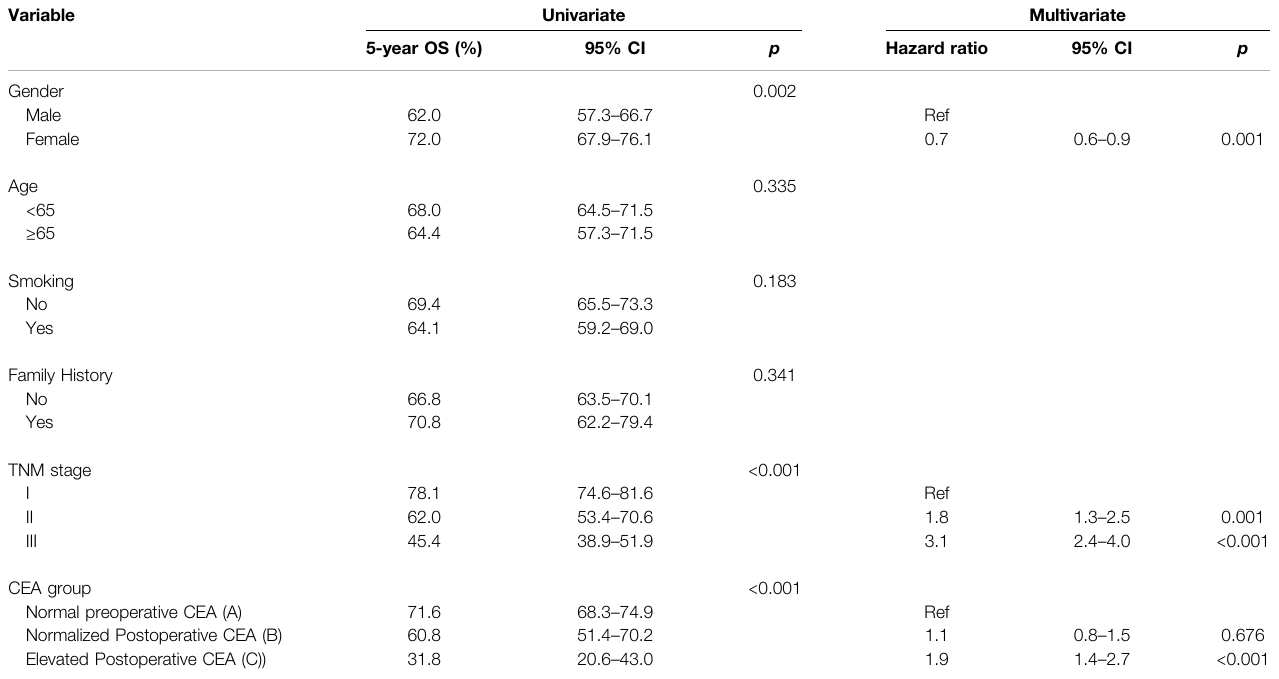
TABLE 4 | Univariate and multivariate analyses of overall survival in ADC.